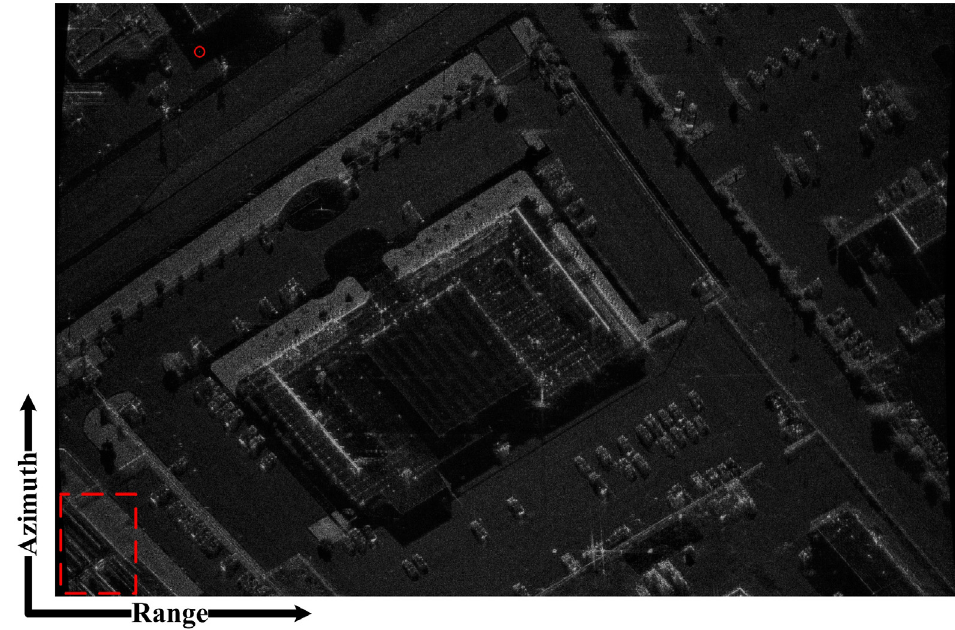
Figure 21. Imaging results of scene simulation using the proposed method.